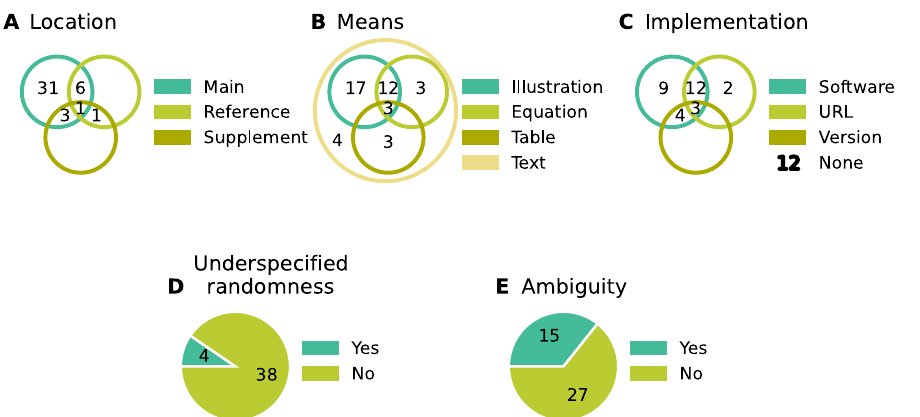
Fig 3. Description: How does the article describe the connectivity and is the description complete? (A) Location of connectivity description. “Main”: in main manuscript; “Reference”: reference to other publication; “Supplement”: in separate file belonging to the same publication. (B) Means used to describe connectivity. Descriptions of the parameterization of connections are only counted if they are crucial for understanding whether connections exist. (C) Reference to model implementation in manuscript. “Software”: name of software given; “URL”: explicit hyperlink or DOI referencing published code; “Version”: software version given; “None”: implementation not mentioned (number of occurrences given in legend). Intersections in panels A–C mean that the connectivity is described in different locations, a combination of different means is used, and different references to the model implementation are given, respectively. (D) Whether connectivity is just specified as “random” or a connection probability is given without defining the connection rule. (E) Whether description is insufficient or inconclusive for implementing the network model.